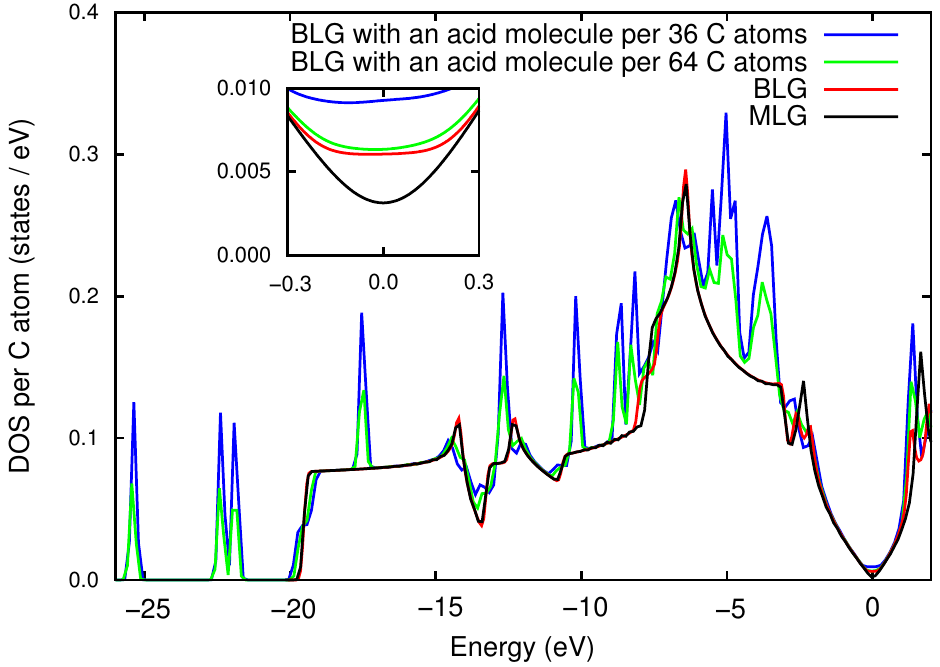
Figure 6. Densities of states per C atom of a bilayer graphene with a chlorosulfonic acid molecule adsorbed per 36 (blue line) and 64 (green line) carbon atoms. The DOS per C atom of MLG (black line) and BLG (red line) is also shown. The Fermi energy has been used as energy